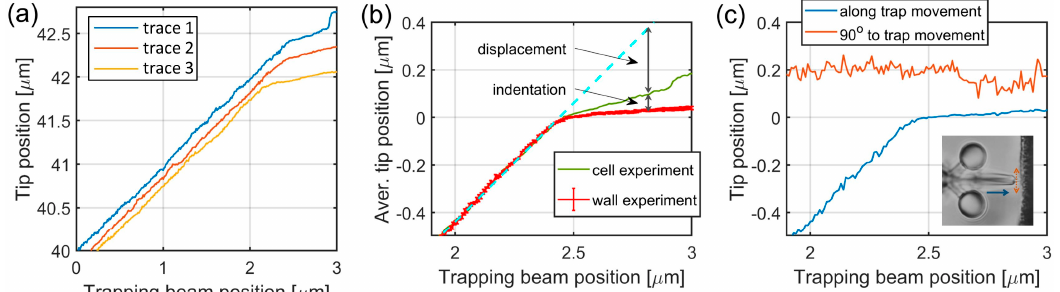
Figure 4. Tip position traces for the calculation of endothelial cell’s Young’s modulus. Panel ( a ) shows representative raw tip position traces as the function of the trap positions, before alignment, obtained from individual cell indentation experiments. After the alignment procedure, the tip positions ( b ) of the wall approach experiments were averaged for background (red curve), while the cell indentation traces (an example is shown by the green curve) were used individually to calculate indentation and displacement. The error bars on the red trace represent standard deviation. At each trapping beam position, the cell indentation was calculated as the di ff erence between the green and red curves, and the microtool displacement as the di ff erence between the green curve and the trapping beam position (dashed light blue curve). Panel ( c ) shows a tip position movement parallel (blue) and perpendicular (red) to the trap movement (that is, axis of the microtool) during the tool being pushed against a hard wall. The inset displays the tip movement along the trap progression (blue line) and perpendicular to it (red